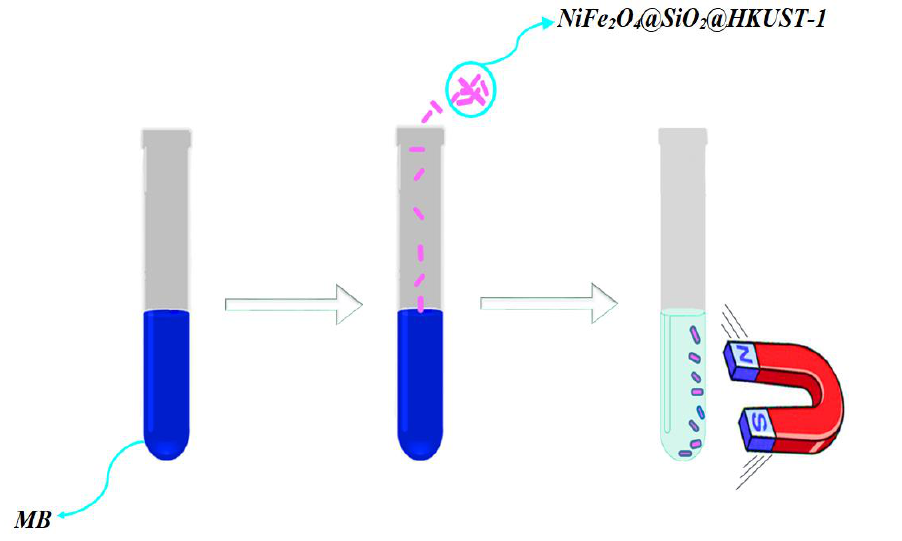
Fig. 12. Schematic of decolorization of methylene blue by magnetic metal-organic framework nanocomposites synthesized